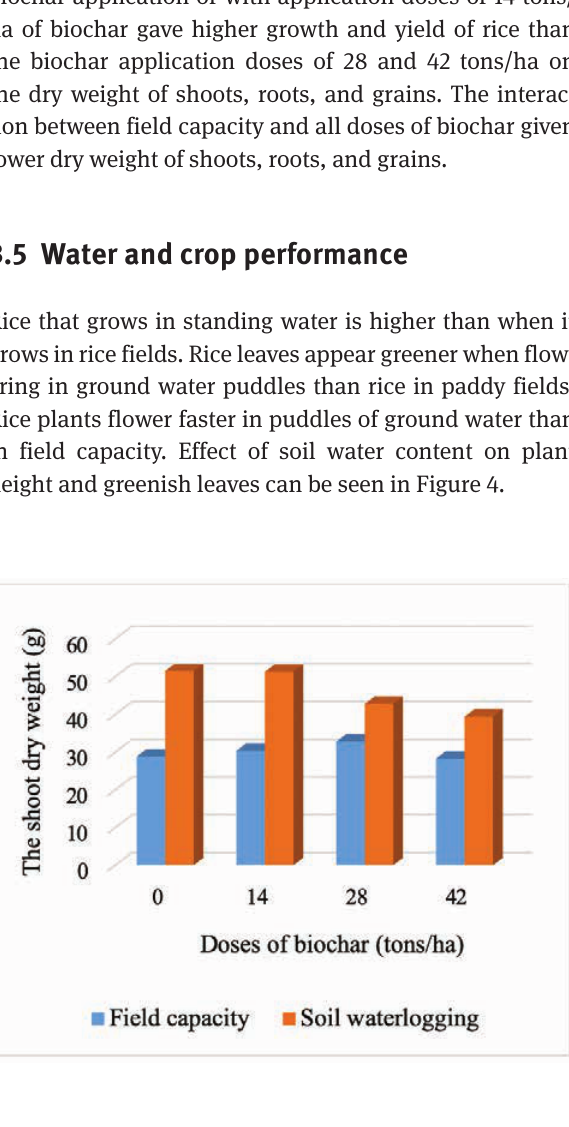
Figure 3: Interaction between Soil Water Content and Biochar Appli- cation on the Grains Dry